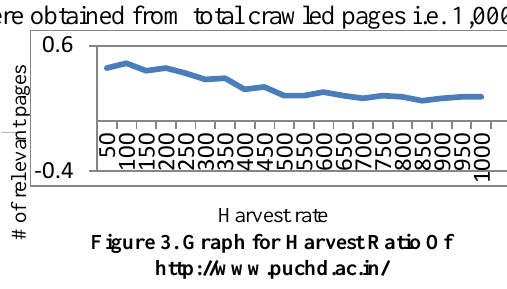
Figure 7. Average Harvest ratio of above three